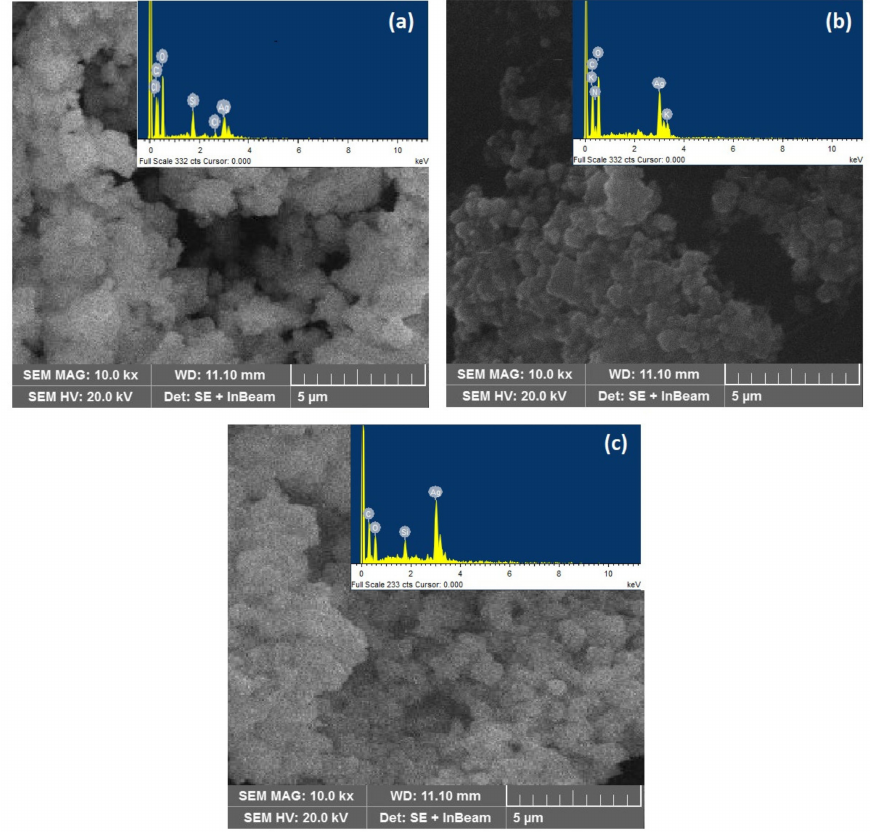
Figure 8. SEM micrographs and EDX spectra of ( a ) glucose stabilized AgNPs (run 3), ( b ) fructose